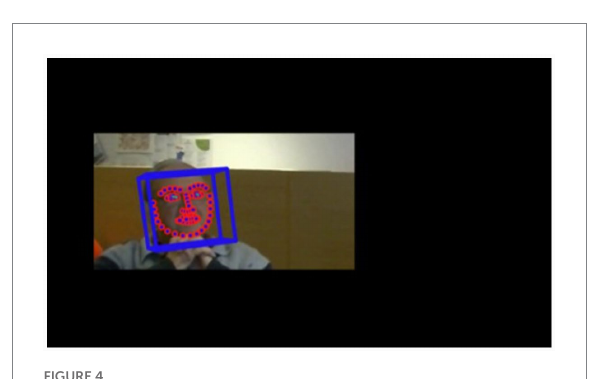
FIGURE 4 A screenshot of a cropped video recording of a Time Travelling with Technology session being processed through